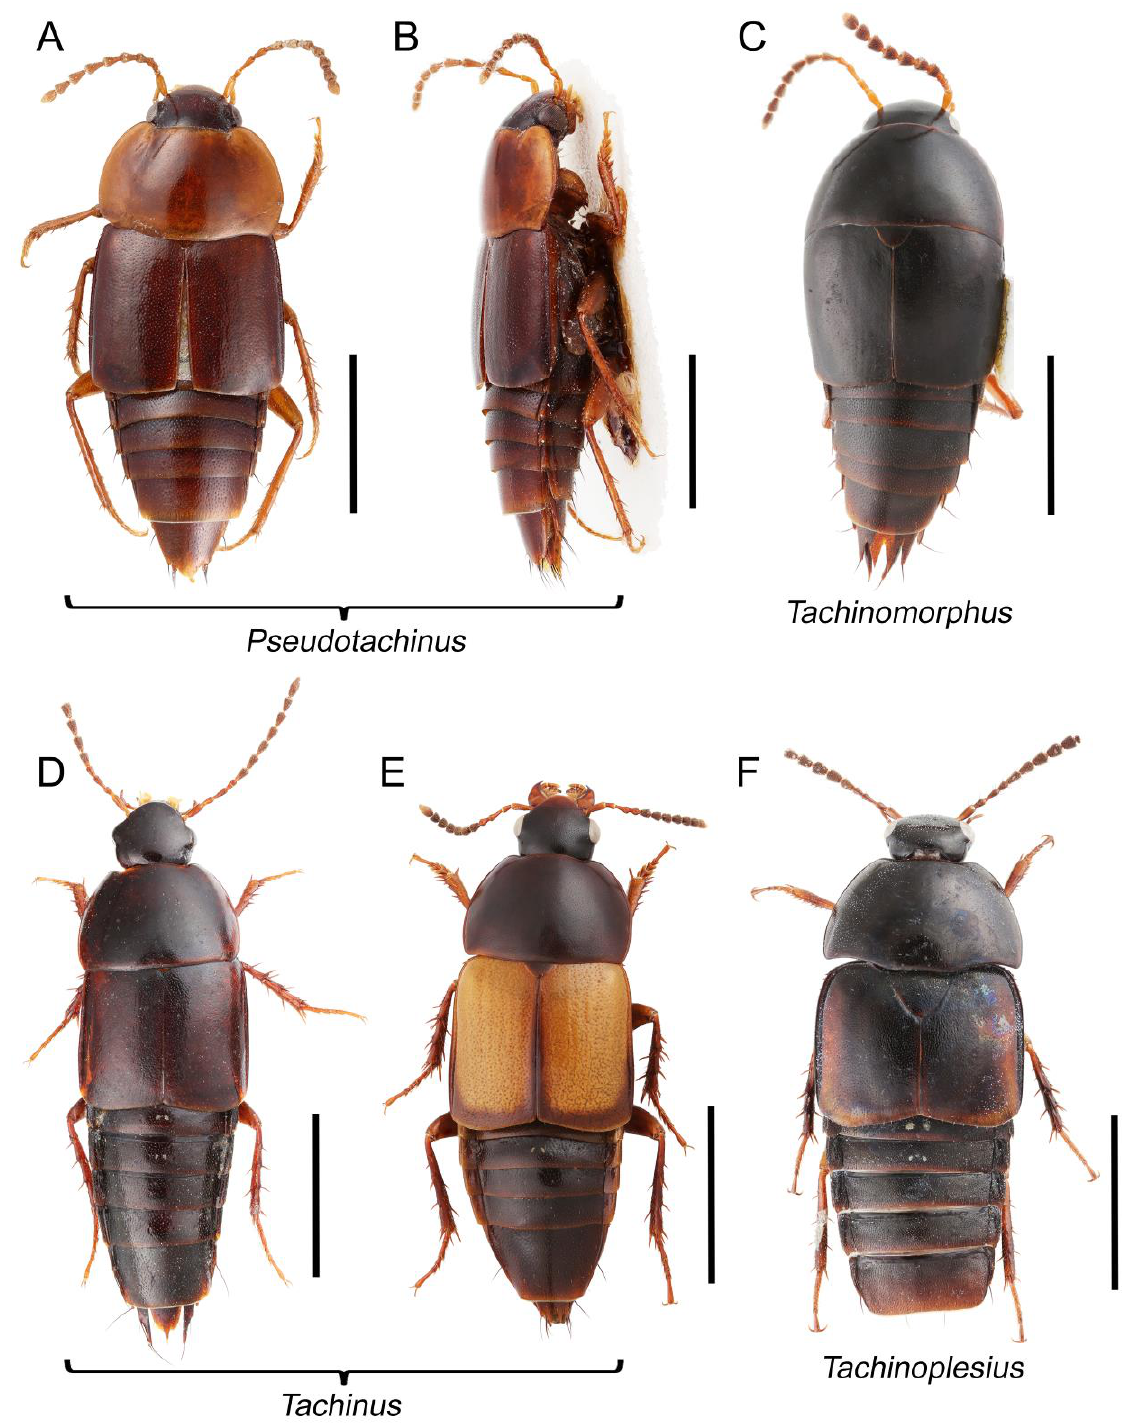
Figure 49. Habitus photographs of Tachinusini. ( A ) Pseudotachinus besucheti Schülke, dorsal view. ( B ) Pseudotachinus besucheti , dorsolateral view. ( C ) Tachinomorphus grossulus (LeConte), dorsal view. ( D ) Tachinus rufipes (Linnaeus), dorsal view. ( E ) Tachinus fimbriatus Gravenhorst, dorsal view. (F) Tachinoplesius latipennis Schülke, dorsal view. Scale bars: 2.0 mm ( A , B , D , F ); 1.5 mm ( C ), 3.0 mm ( E